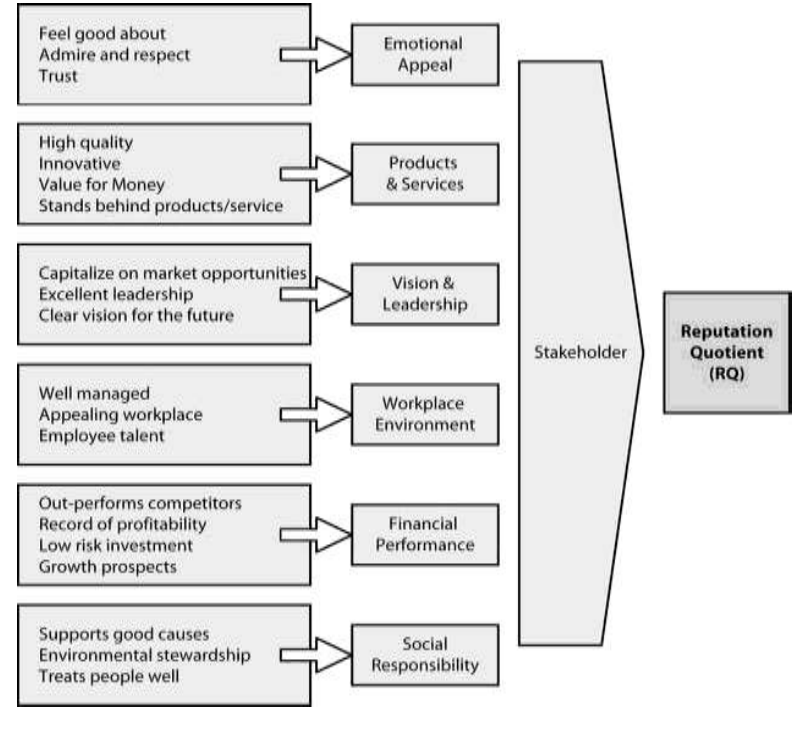
Figure 2: Reputation Quotient (RQ) Source: Wiedmann, Fombrun, Riel